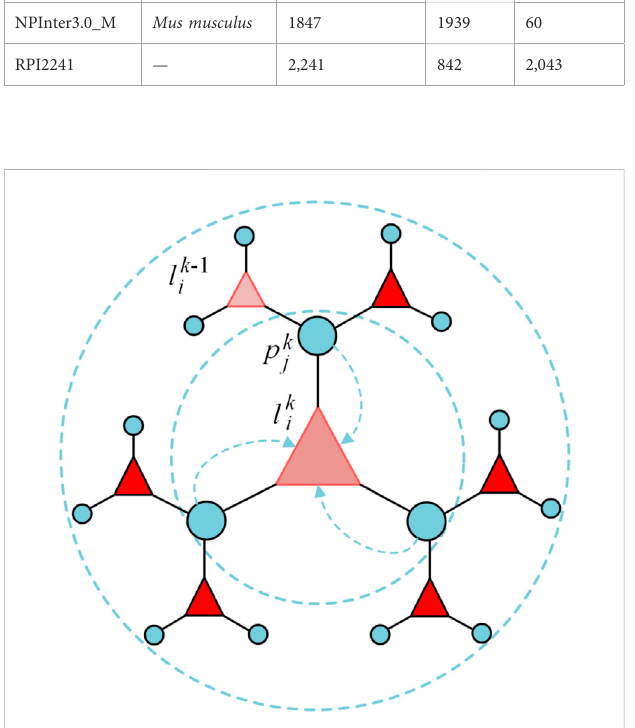
FIGURE 1 The forward propagation process of node from l k − 1 i to l k i